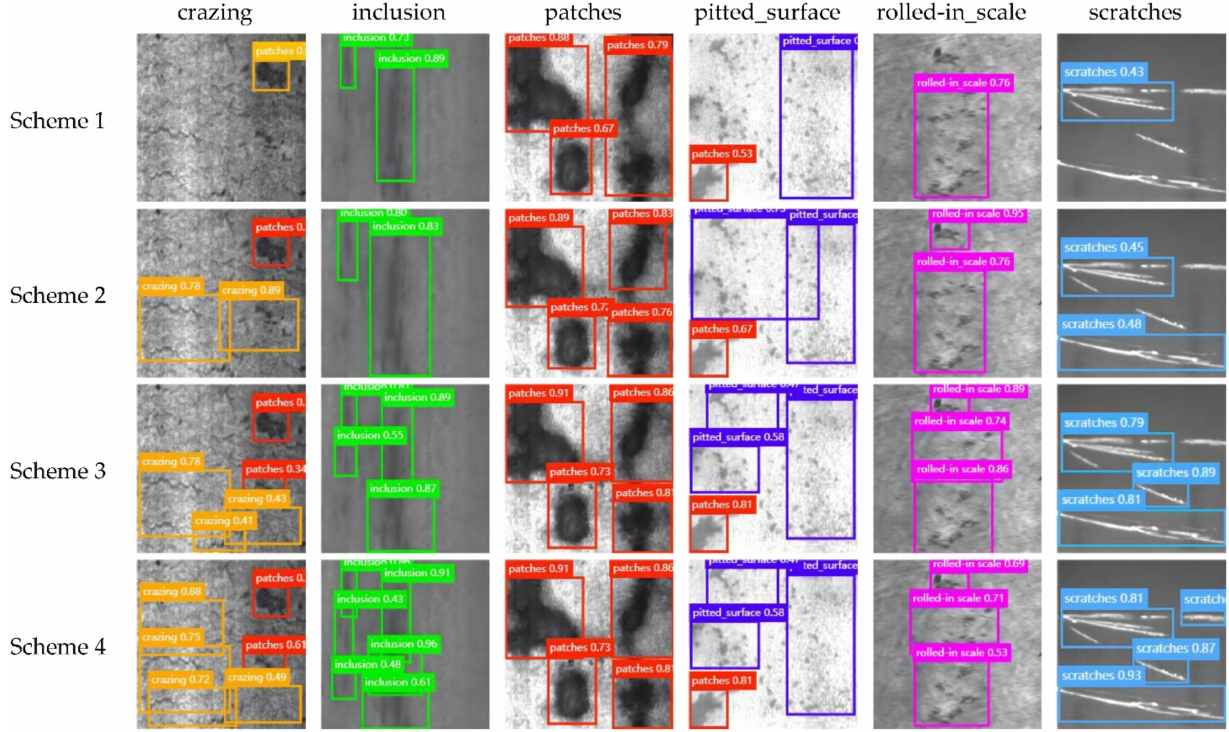
Figure 13. Visualized results of different